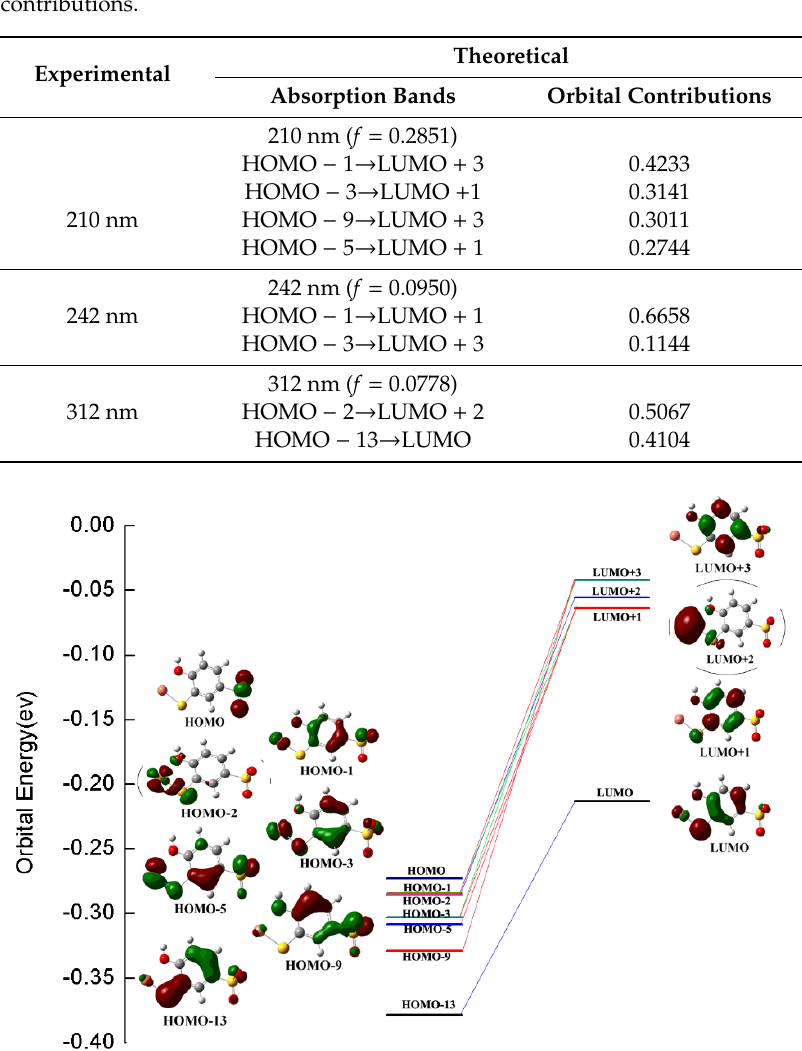
Figure 4. Topologies of molecular orbital involved in electronic transitions of main absorption bands.